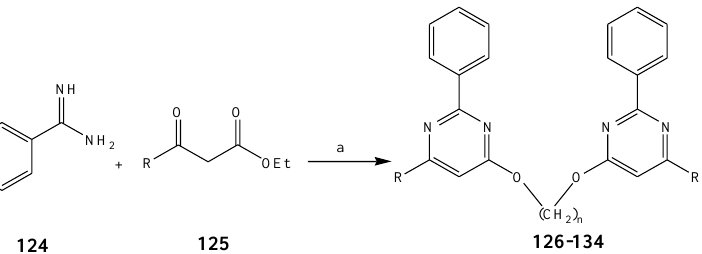
Scheme 10. Synthesis of pyrimidine using acetamidine and isonicotinamidine.